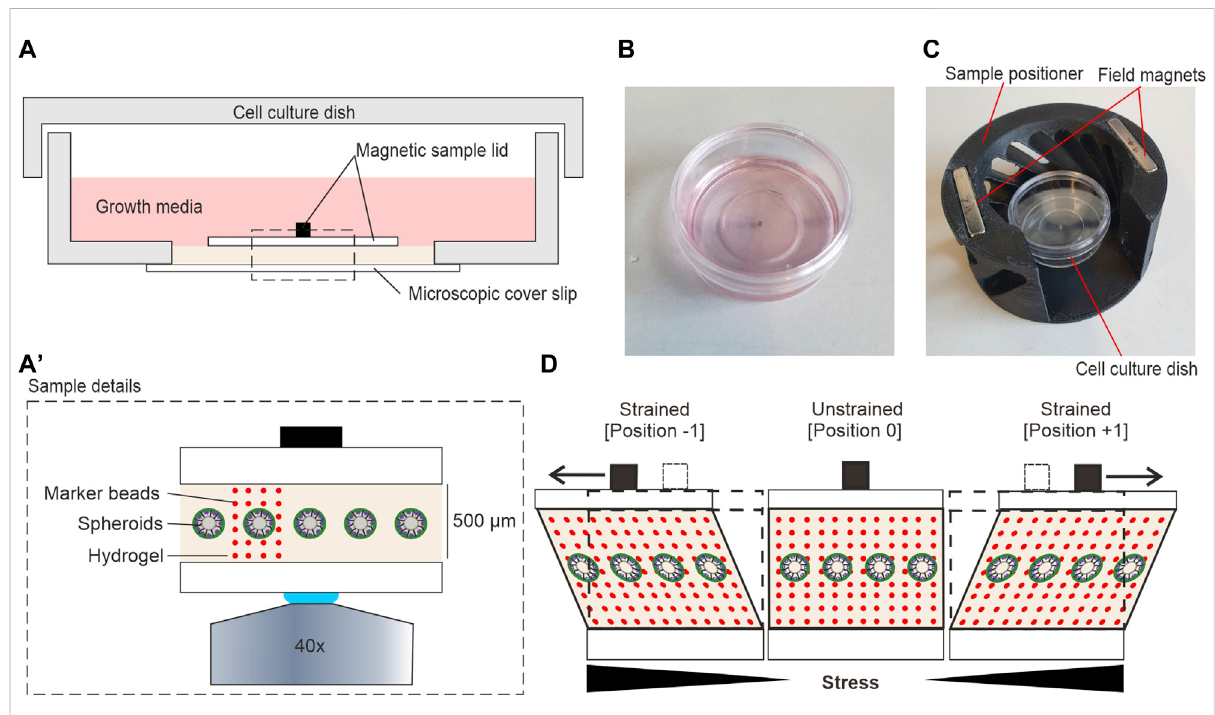
FIGURE 2 Hydrogel sample setup for shear stress application. (A) Detailed view on the shear strain sample within a 35 mm cell culture dish. (A 9 ) Magni fi cation of highlighted area (dashed line) in (A) (B) A sterile ready-to-use sample. (C) A sample was placed into the magnetic positioner before mounting in the magnetic fi eld of the moving sled. (D) The cartoon highlights the principle of sample movement and shear stress application. Sled movement (not shown) generates a pulling force (black arrows) on the sample magnet. In strained positions, spheroids and the gel are both sheared. Local displacements at individual confocal image planes can be tracked by incorporated fl uorescent marker beads (red